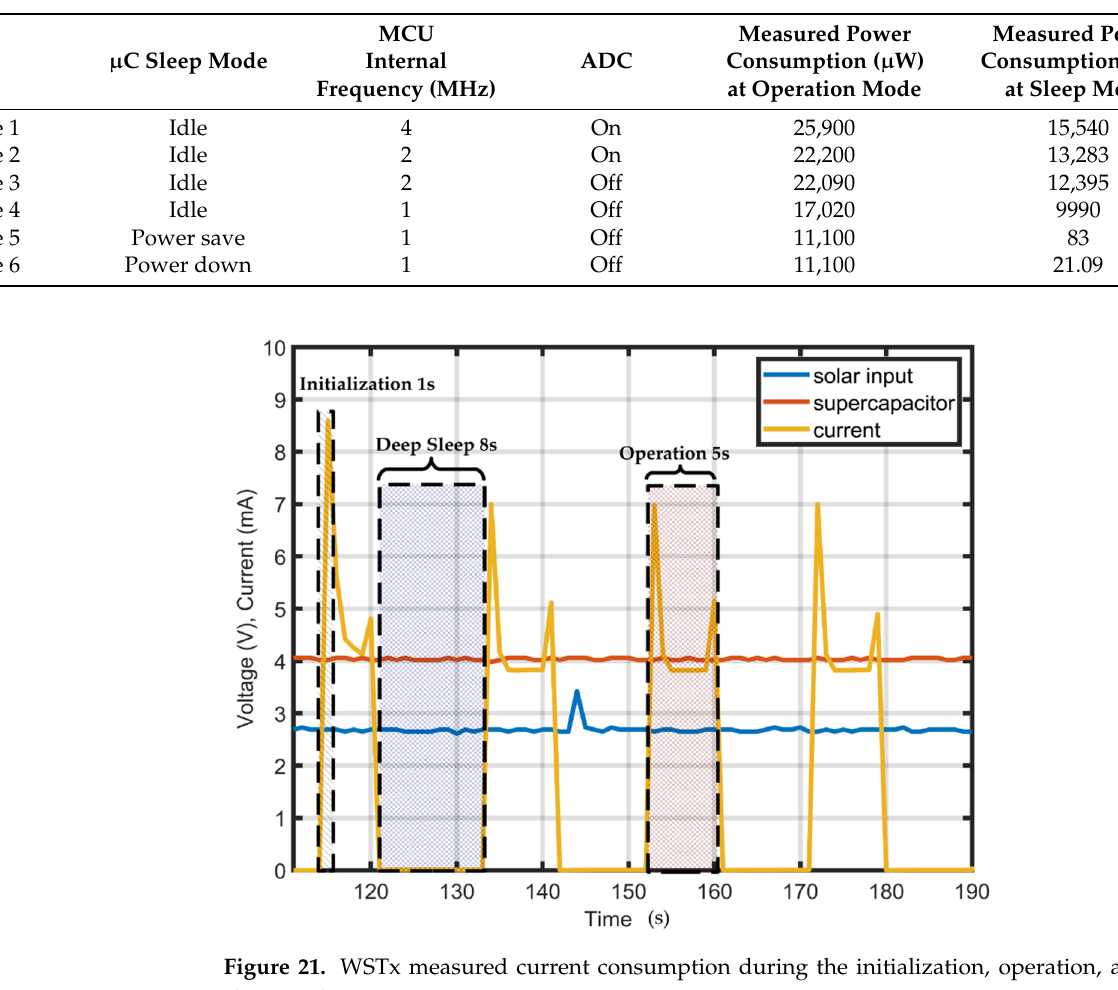
Table 3. Comparison of power consumption with different firmware configurations (at 3.7 V, Tx gain 7 dBm).